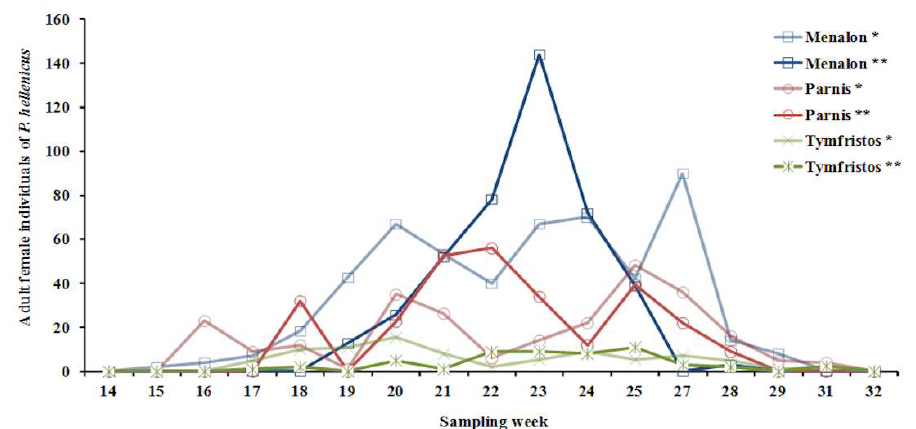
Figure 6. Mean value of the alive female adults of P. hellenicus inside nodes of Abies spp. during the entire sampling period at Menalon, Parnis and Tymfristos per week of the year and per amount of honeydew (* = one drop of honeydew behind the insect, ** = many drops diffusible all over the insect).